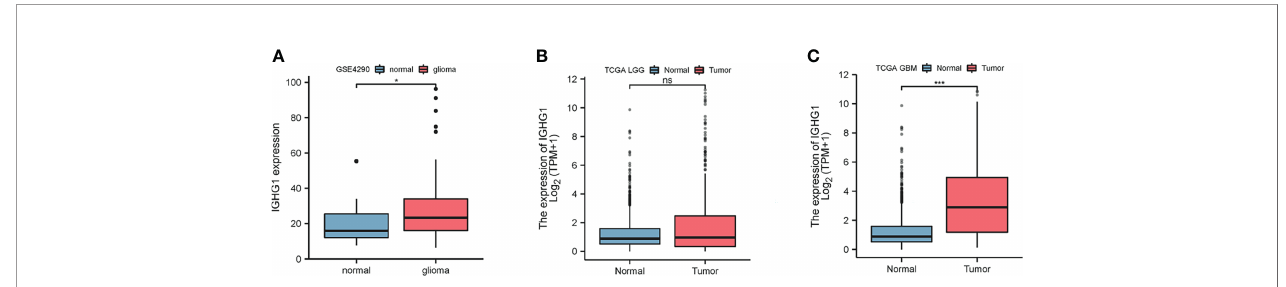
FIGURE 1 | Differences in the expression of IGHG1 between glioma and normal brain tissues. (A) In the GSE4290 dataset, the expression of IGHG1 differed between glioma and normal brain tissues. (B) In The Cancer Genome Atlas (TCGA) cohort, there was no signi fi cant difference in the expression of IGHG1 in lower grade glioma (LGG) and normal brain tissues. (C) The expression of IGHG1 in glioblastoma (GBM) was signi fi cantly higher than that in normal brain tissue in TCGA. * represent P < 0.01. *** represent P < 0.0001 and ns, represent no signi fi